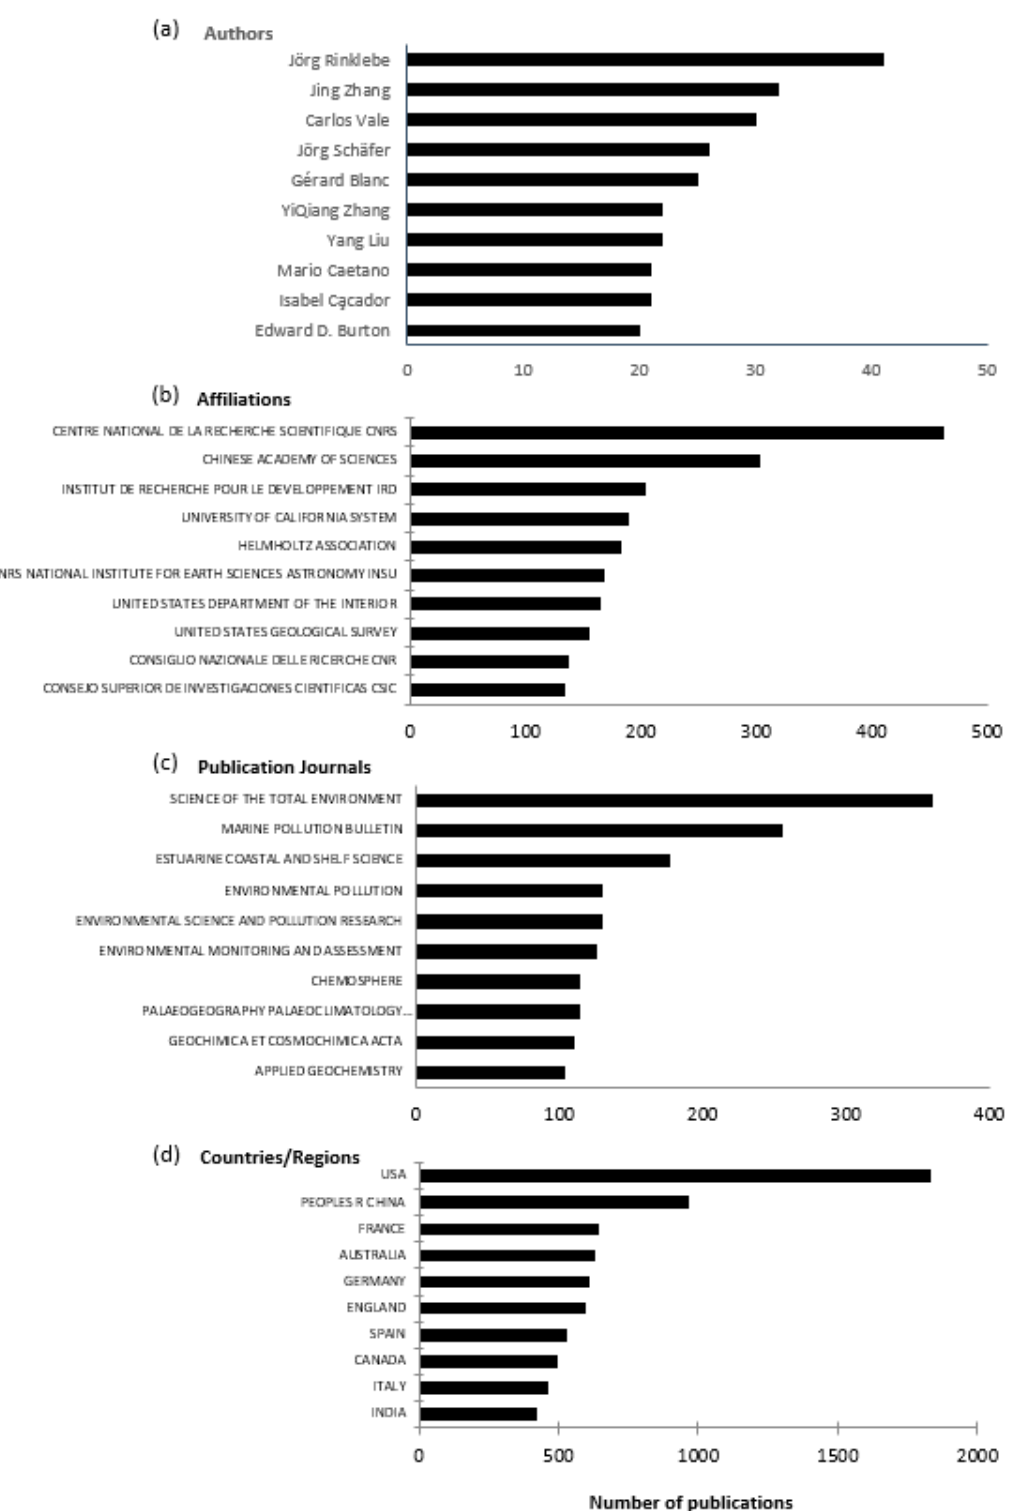
Figure 2. The top 10 contributors of studies related to the impacts of climate change on heavy metal contamination in coastal areas, based on the Web of Science Core Collection database (1979–2021): ( a ) authors; ( b ) affiliations; ( c ) publication journals; ( d ) countries.